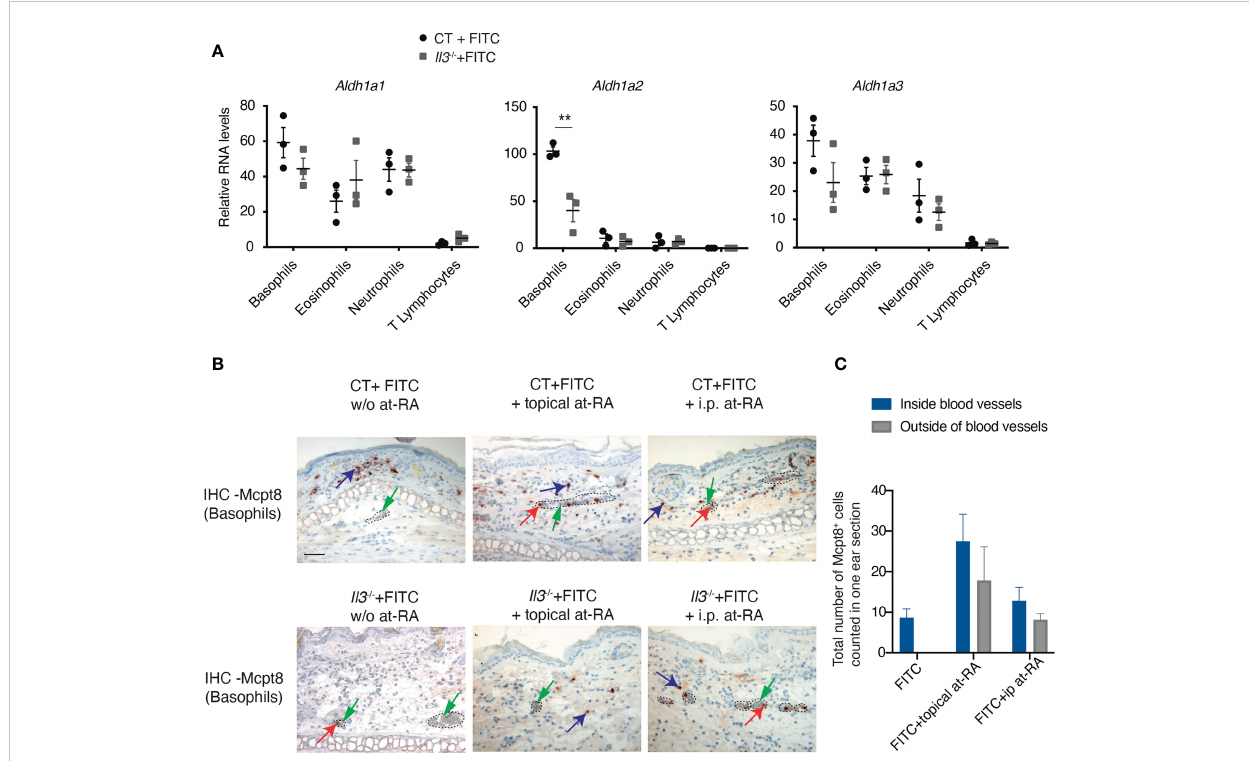
FIGURE 6 All-trans retinoic acid treatment prior to FITC challenge promotes basophil recruitment to ACD skin. (A) RT-qPCR analyses of retinaldehyde dehydrogenease genes Aldh1a1, Aldh1a2, and Aldh1a3 in basophils, neutrophils, eosinophils and T cells sorted from FITC-treated Il3 -/- and CT ears. **P ≤ 0.01 (Student's t-test). Values are mean ± SEM (n=3). (B) Il3 -/- and CT mice were FITC-sensitized and -challenged as described in Figure 1A. Mice were either topically treated with all-trans retinoic acid (at-RA) on RE at 2 hr before FITC-challenge, or intraperitoneally (i.p.) administrated with at-RA at 24 hr before FITC-challenge. RE sections from Il3 -/- and CT mice were used for MCPT8 IHC. Blue arrows point to one of the positive cells outside of blood vessels; red arrows point to one of the positive cells inside blood vessels; green arrows point to red blood cells inside the vessel. Dashed circles outline blood vessels. Scale bar: 50 m m. (C) Comparison of total number of Mcpt8 basophils inside and ourside of blood vessels from ear sections of Il3 -/- mice treated with FITC, FITC+topical at-RA, or FITC+i.p. at-RA. Values are mean ± SEM